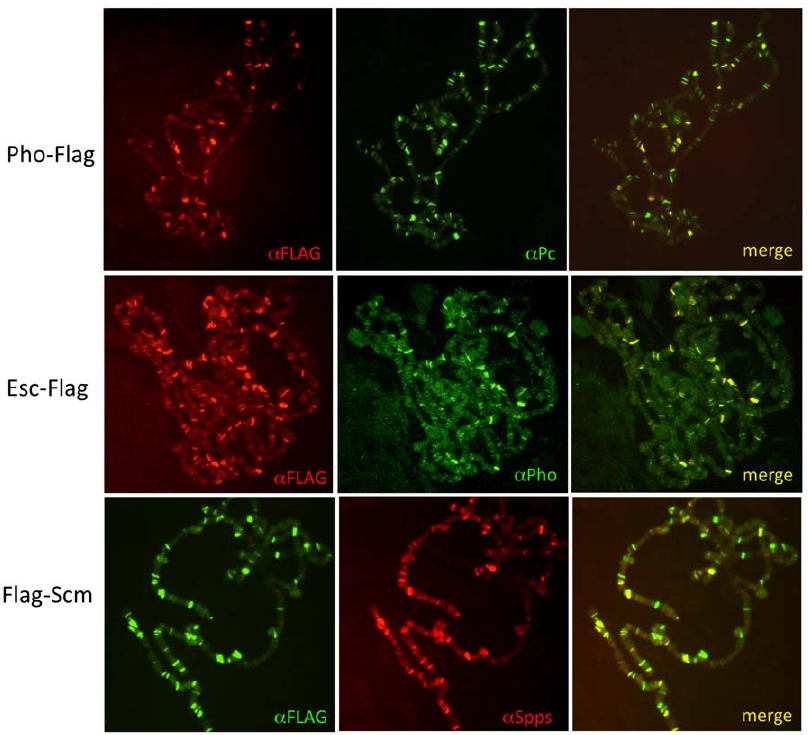
Figure 3. FLAG-tagged PcG proteins co-localize with endogenous PcG proteins on polytene chromosomes. FLAG-tagged proteins were driven by arm -Gal4.